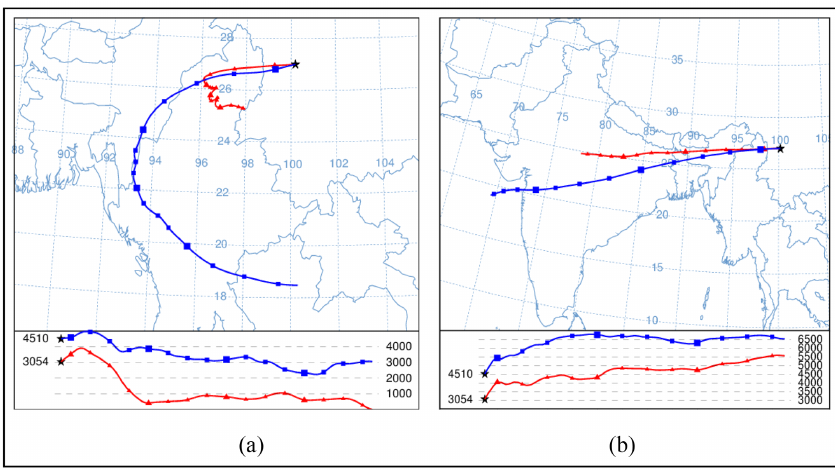
Figure 7. Seven-day backward trajectory analysis with the HYSPLIT model (a) in the monsoon and (b) post-monsoon seasons during the study period (Source (cid:63) at 27.01 ◦ N, 100.20 ◦ E). The trajectories of air mass in the plot were the average of a few episodes. The two heights are the elevation of Mt. Yulong and GHZ, respectively.